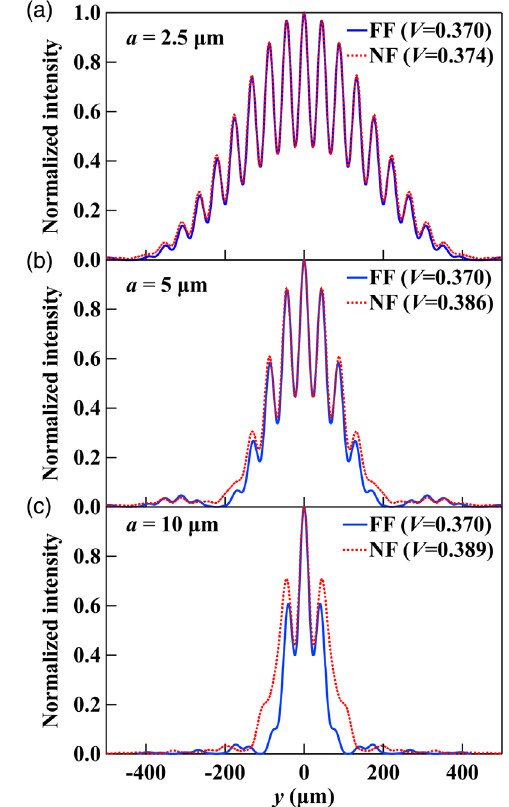
FIG. 8. Simulated double-slit interference profiles using (solid curves) far-field formula Eq. (12) and (dotted) near-field (Fresnel) calculation with different slit widths a ¼ ð a Þ 2 . 5 , (b) 5.0, and (c) 10 μ m. The other calculation parameters are λ ¼ 0 . 827 Å ( E ¼ 15 keV), p ¼ 6 . 6 m, q ¼ 13 . 4 m, σ d ¼ 25 μ m. The figure shows the failure of the far-field approxi- mation for large slit width a .